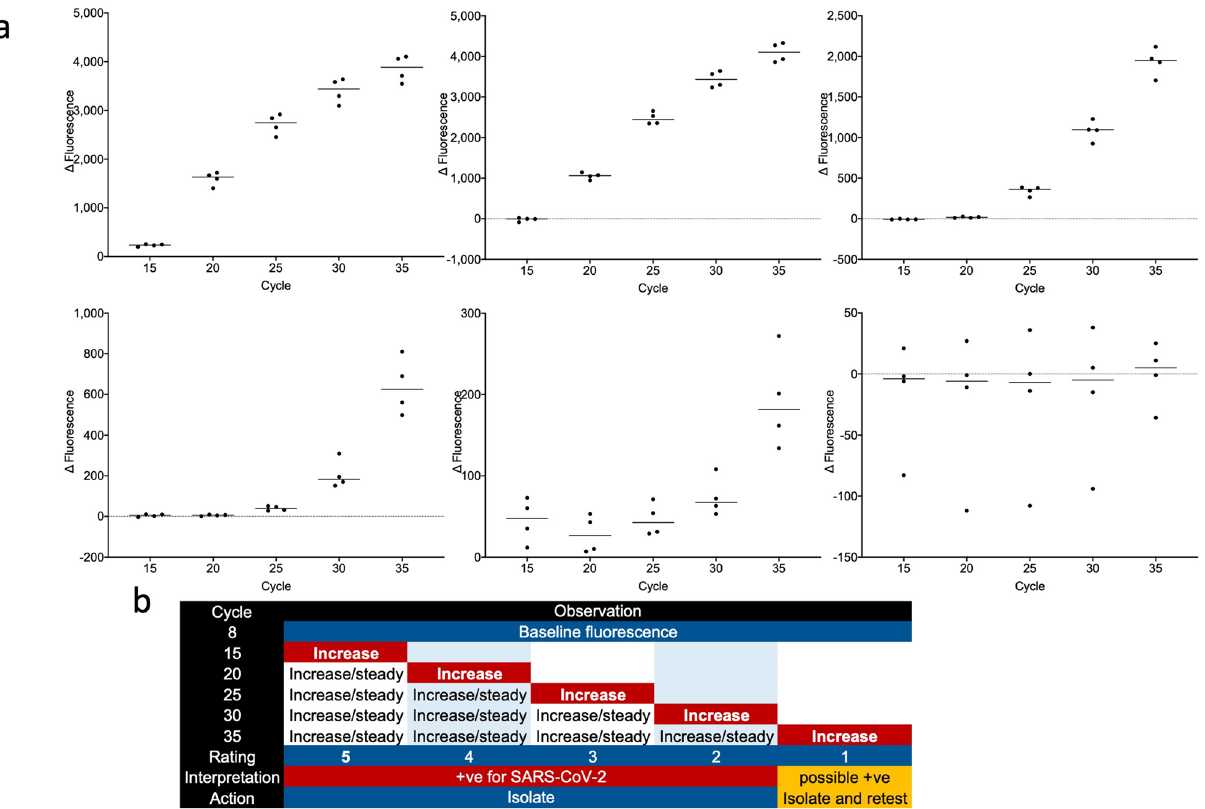
Figure 6. Multiple cycle fluorescence detection PCR results. ( a ) Four replicates were assayed for five samples containing different concentrations of Nsp12 amplicons, together with a NTC. Fluorescence data were collected at cycles 8, 15, 20, 25, 30 and 35 and for each replicate the fluorescence recorded at cycle 5 was subtracted from the fluorescence recorded at each subsequent fluorescence collection cycle. The difference in fluorescence was plotted for each cycle, with the horizontal bar indicating the median fluorescence. The run took just over 22 min to complete. ( b ) Algorithm incorporating the fluorescence data into a diagnostic assessment tool, obviating the need to deal with Cqs and